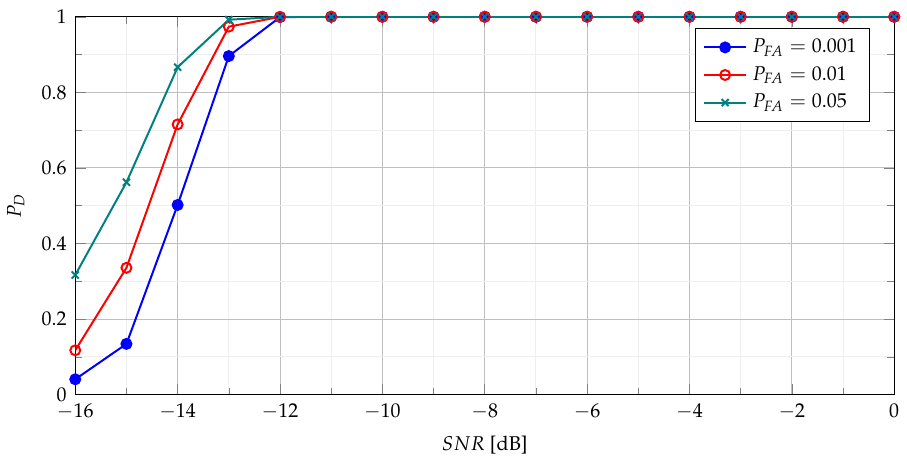
0,1 . 0,1 . 0,1 . Figure 5. Probability of detection with use of the TSCPF statistics employing slices n = 0,1 . { } { } { } { }